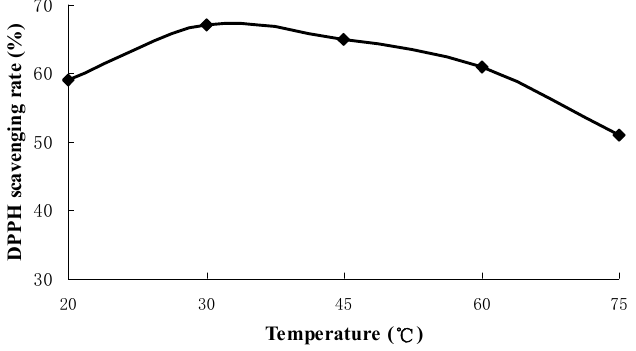
Figure 3. The influence of temperature on antioxidant activities of